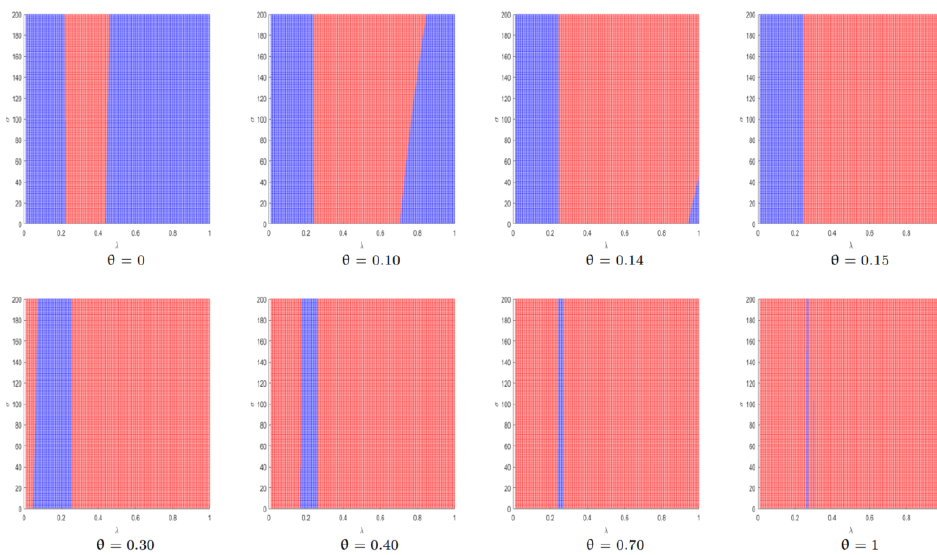
Figure 18. Bundle option of the ride-hailing platform with the combination of λ and σ .